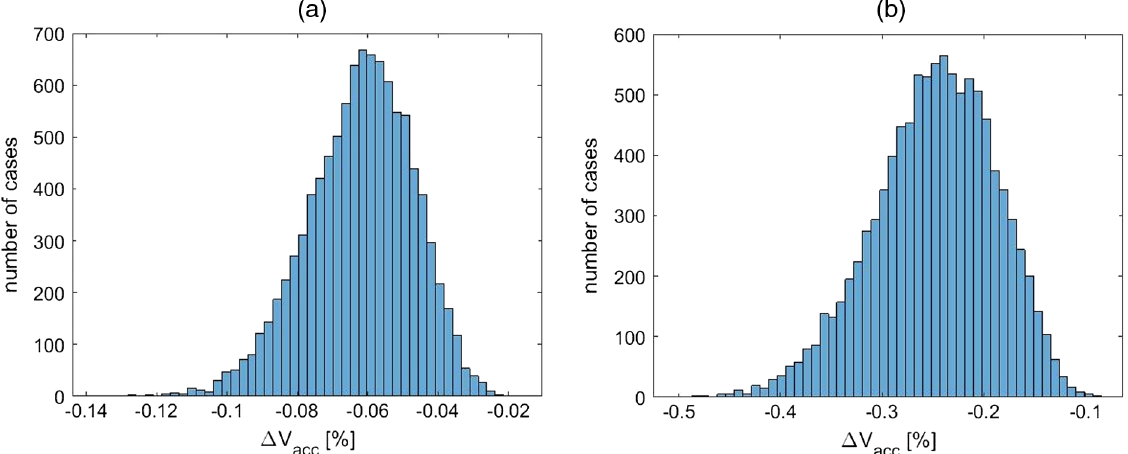
FIG. 21. Distribution of the reduction in the average accelerating voltage calculated considering 10 4 random cases: (a) maximum cell- ¼ (cid:1) 2 ° and maximum cumulative phase advance error along the structure ( ϕ to-cell phase advance deviation of Δ ϕ ) within (cid:1) 5 ° n cum (mean value − 0 . 07 %, standard deviation − 0 . 015 %, minimum value − 0 . 15 %); (b) maximum cell-to-cell phase advance deviation of Δ ϕ ¼ (cid:1) 4 ° and maximum cumulative phase advance error along the structure ( ϕ ) within (cid:1) 10 ° (mean value − 0 . 2485 %, standard n cum deviation − 0 . 06 %, minimum value − 0 . 5